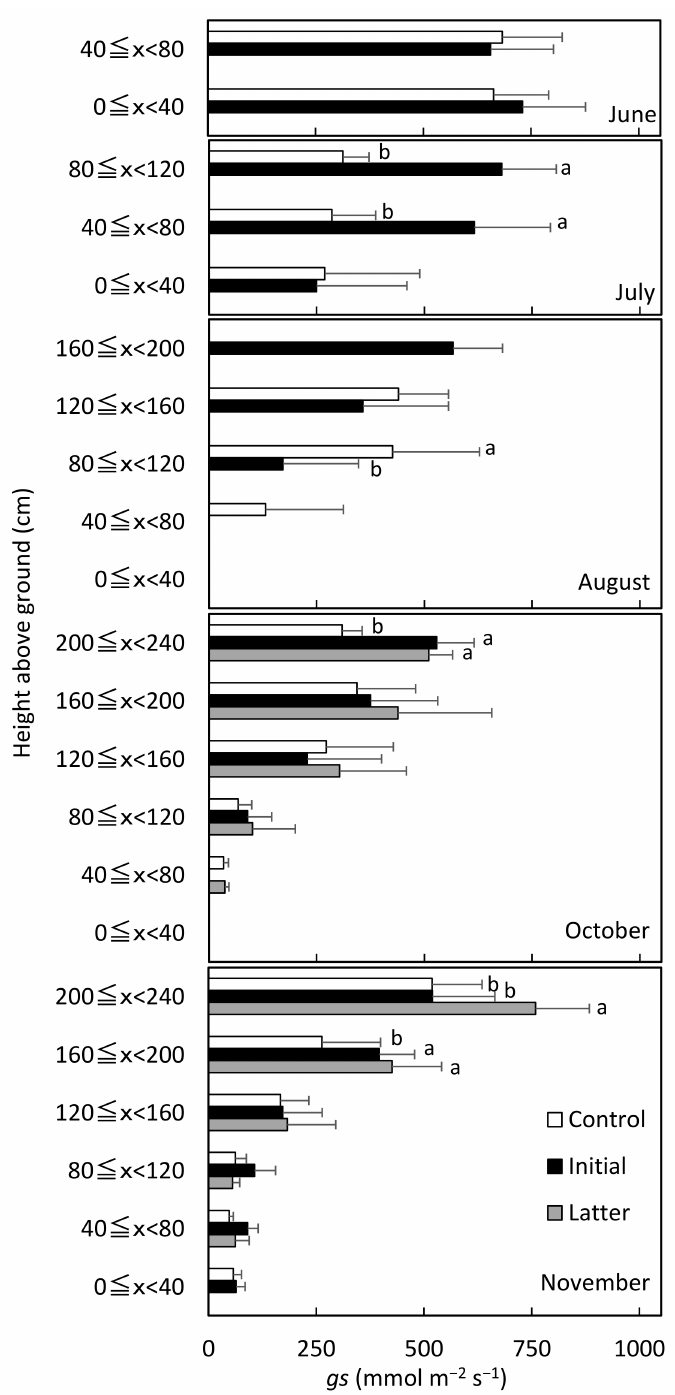
Figure 6. Stomatal conductance ( gs ) of leaves at different canopy levels with 40 cm interval from June to November. The value shown is an average of readings from the control, initial, and latter fertilization treatments. Different letters represent statistically significant differences ( p < 0.05) among the